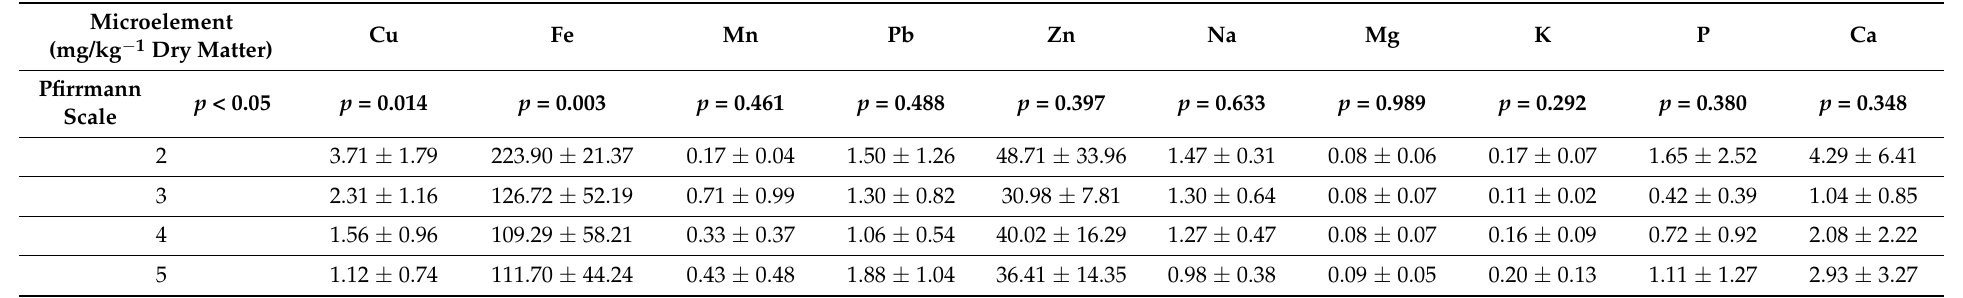
Table 7. Concentrations of selected elements in degenerated intervertebral discs, depending on the degree of radiological degeneration, according to the Pfirrmann